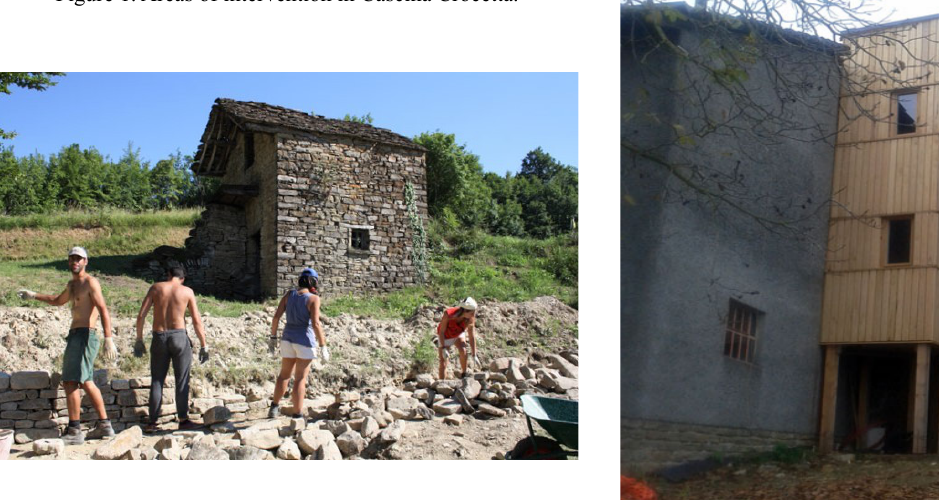
Figure 2. The construction of a dry-stone wall